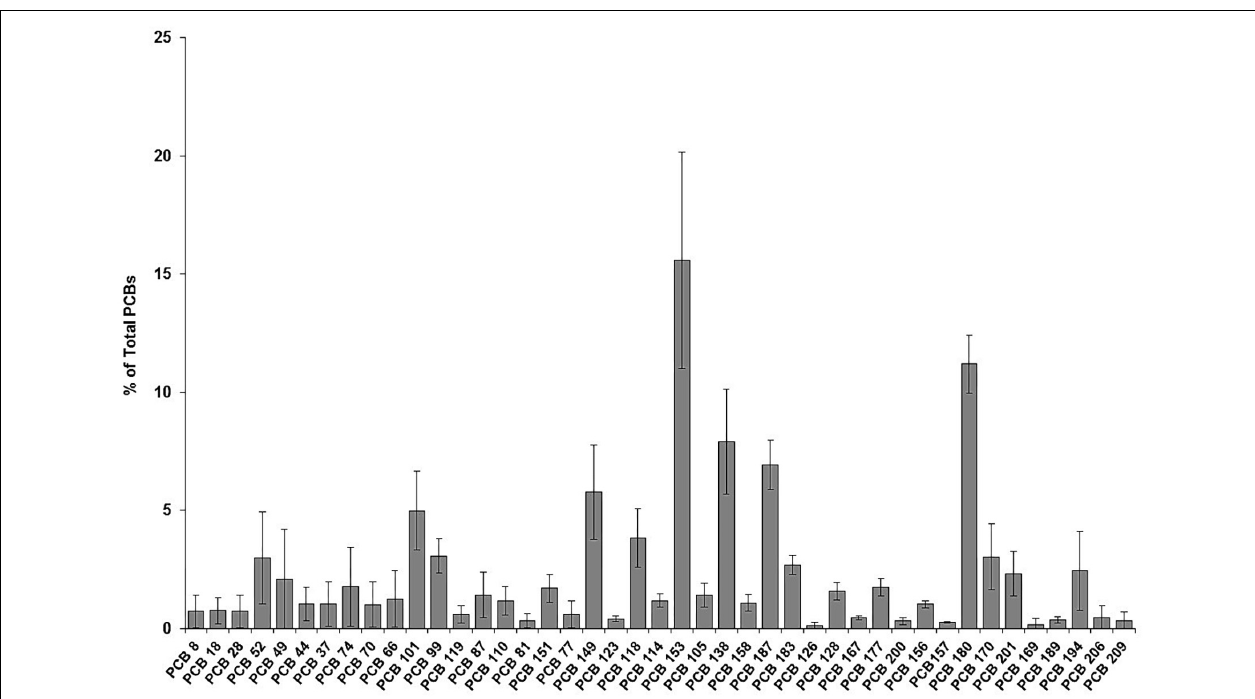
FIGURE 3 | Composition patterns of PCB congeners relative to total PCBs in blubber samples of bottlenose dolphins of the El Morro Mangrove Wildlife Refuge, and Posorja Port, Gulf of Guayaquil, Ecuador. The hexa-chlorobiphenyls, PCB 153, accounted for most of the proportion of PCBs.